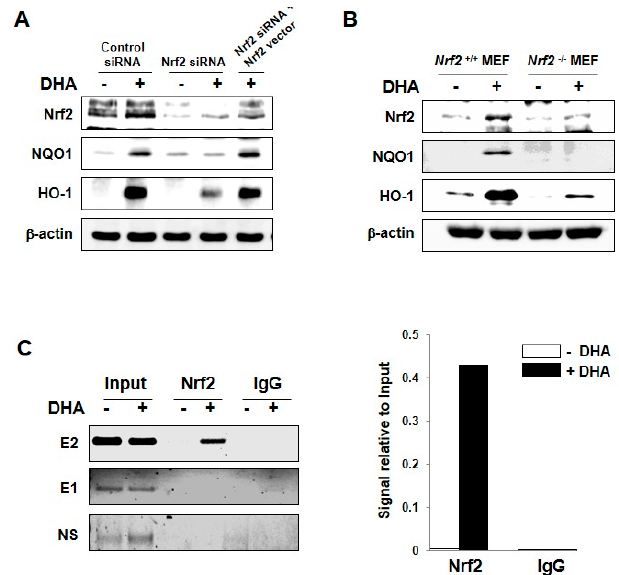
Figure 3. Role of Nrf2 in DHA-induced expression of HO-1 and NQO1. ( A ) MCF-10A cells were transfected with siRNA control, siRNA Nrf2, or siRNA Nrf2 plus Nrf2 full-sequence vector for 12 h and exposed to DHA (25 μ M) for another 9 h. Whole cell lysates were subjected to Western blot analysis. ( B ) Nrf2-WT or Nrf2-null MEF cells were incubated with 25 μ M of DHA for 12 h, and the expression of Nrf2, HO-1, and NQO1 was measured by Western blot analysis. ( C ) MCF-10A cells were treated with DHA (25 μ M) for 9 h and harvested to determine the ARE binding activity by the ChIP assay. Chromatin immunoprecipitated DNA was analyzed by RT-PCR with primers for distal E2 ( − 9.0 kb region) and E1 ( − 4.0 kb region) AREs as well as non-speci fi c region (after − 9.0 kb) of the HO-1 promoter.